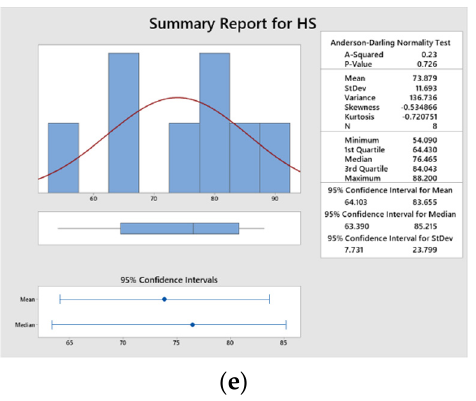
Figure 13. Statistical analysis of ( a ) tensile strength ( b ) flexural strength ( c ) compressive strength ( d ) impact strength ( e ) hardness.